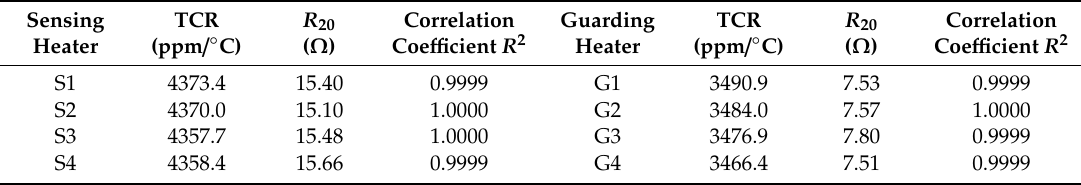
Table 1. The basic parameters of four dual-layer hot film sensors.